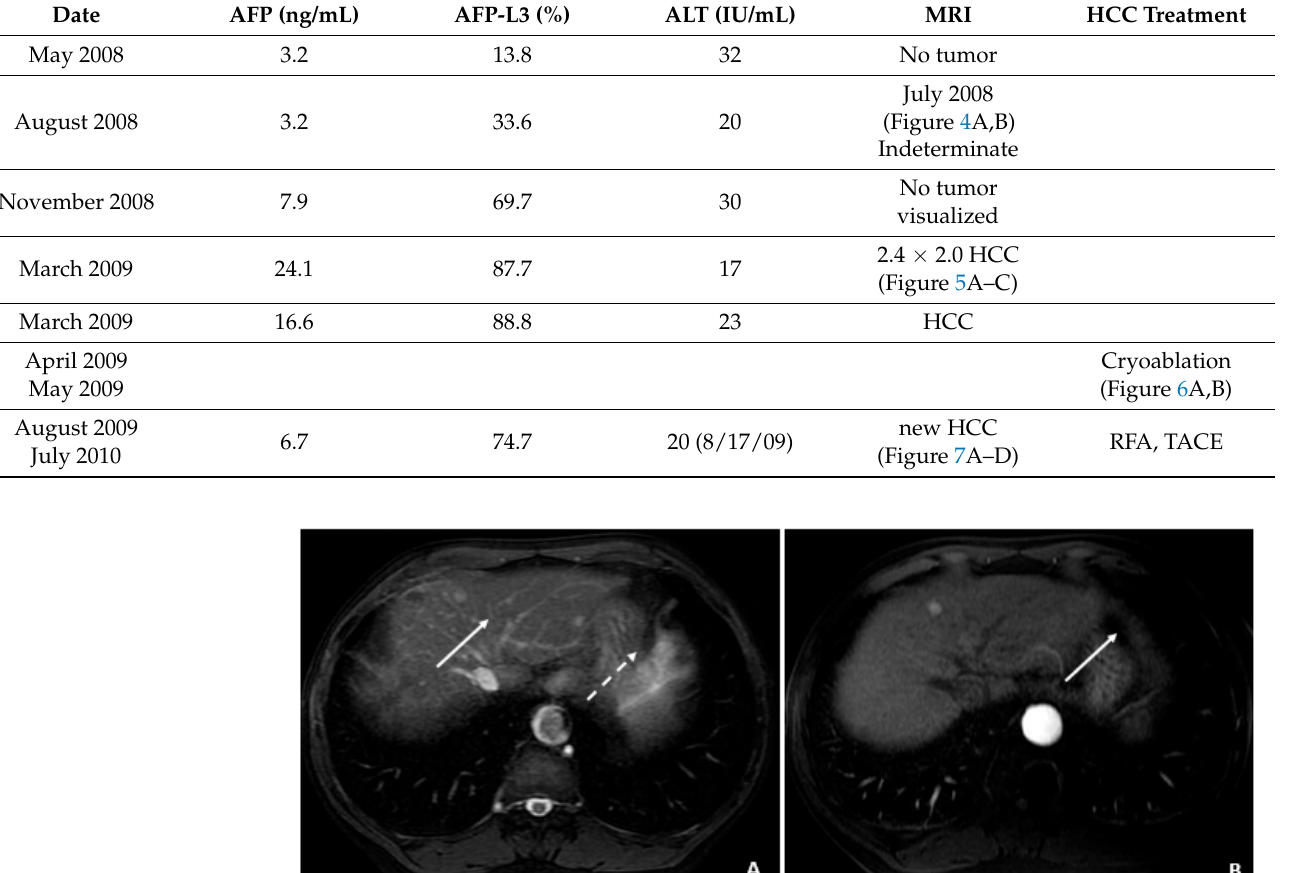
Table 5. Case 5. AFP, L3%, ALT, and imaging findings at time of HCC screening, diagnosis, and at various treatment points.